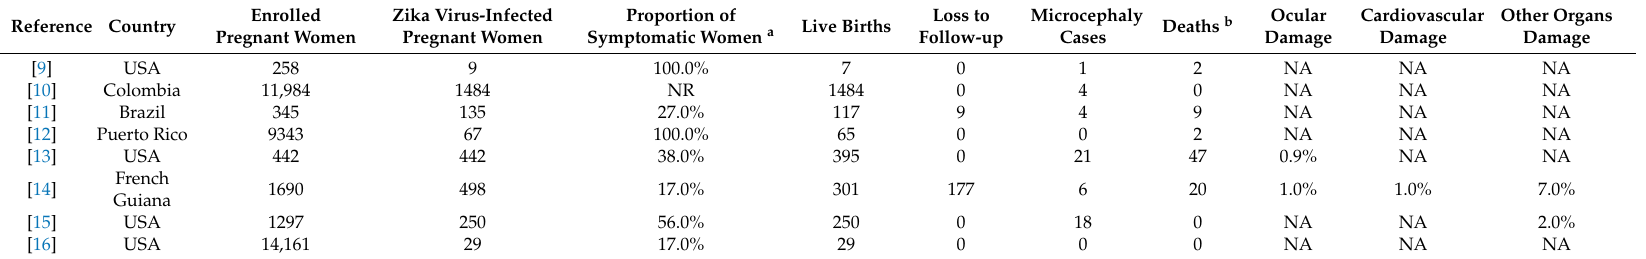
Table 1. Summary of studies’